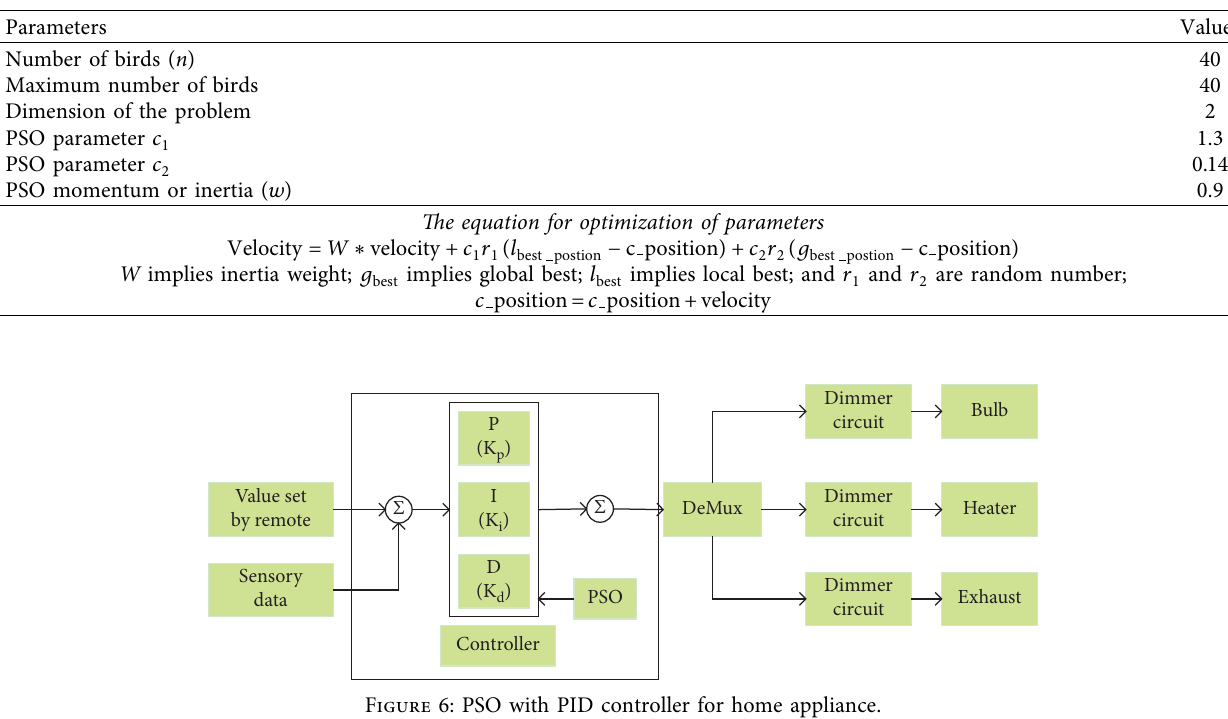
Table 2: Parameters selected in the PSO algorithm.